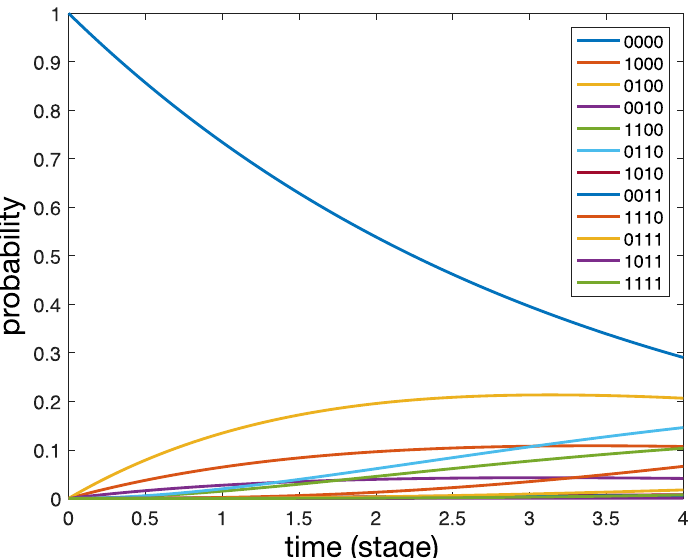
Fig 6. A solution to Eq (3) with parameter values obtained from the maximum likelihood method. Each curve correspond to specific state of the system.